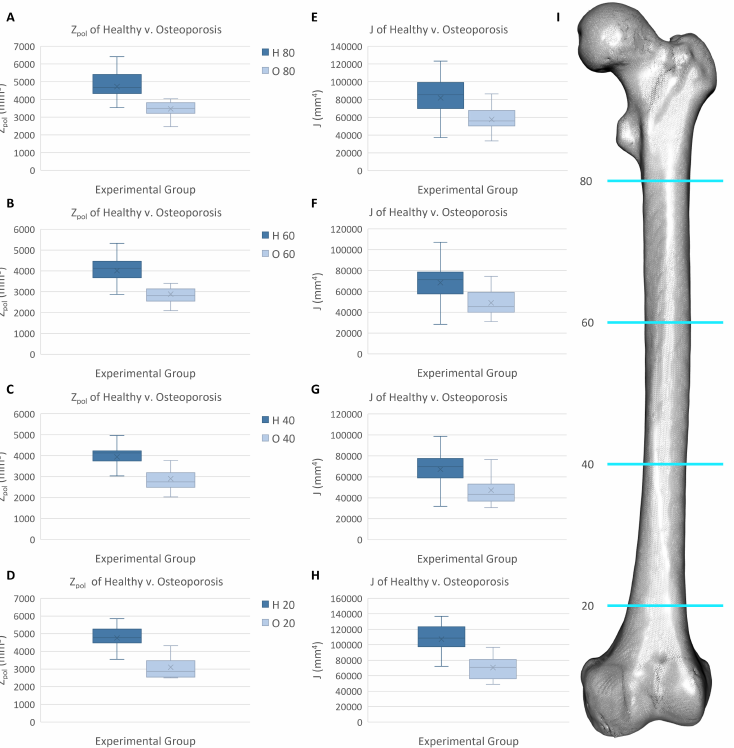
Figure 5. Biomechanical data of the healthy and osteoporosis experimental groups at four sampling locations along the biomechanical length (BL) of the femur. ( A ) Polar section modulus ( Z pol ) at 80% BL. ( B ) Z pol at 60% BL. ( C ) Z pol at 40% BL. ( D ) Z pol at 20% BL. ( E ) Polar moment of inertia ( J ) at 80% BL. ( F ) J at 60% BL. ( G ) J at 40% BL. ( H ) J at 20% BL. ( I ) Femur 3D model showing sampling locations